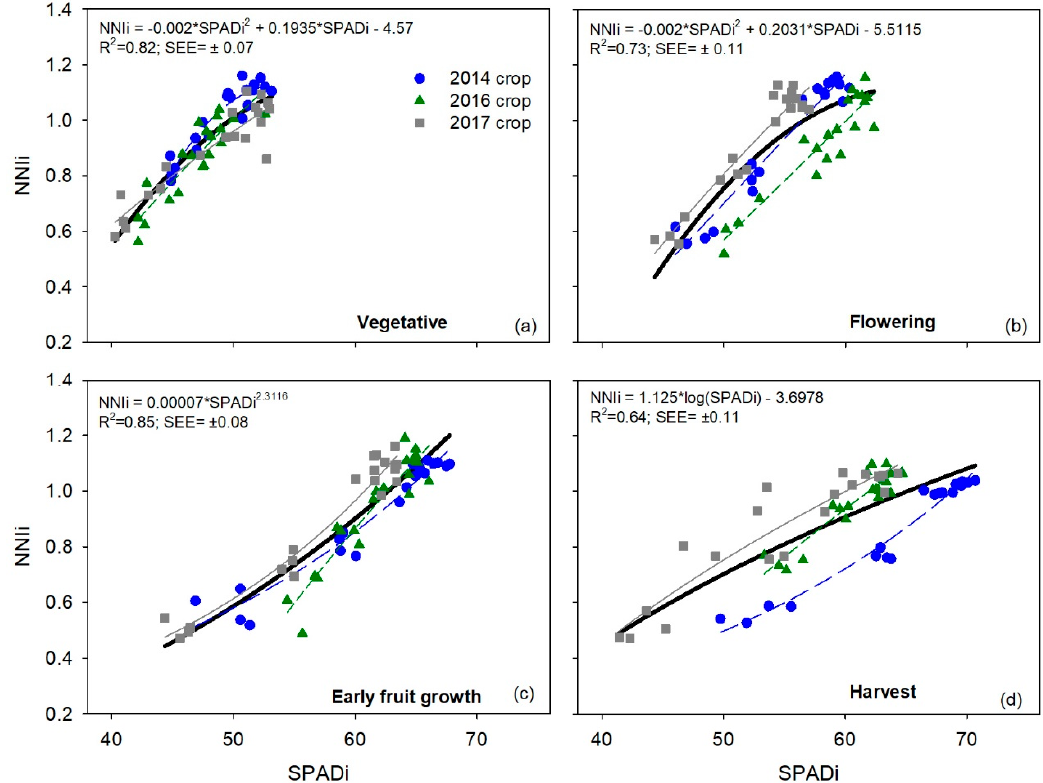
Figure 3. Relationships between integrated SPAD ( SPADi ) values and the integrated crop nitrogen nutrition index ( NNIi ) for each phenological stage in each of the three sweet pepper ( Capsicum annuum ) crops. Each crop was subjected to five different N treatments with four repetitions. The bold black line and the equation represent the adjustment for the combined dataset of the three crops together. Results of regression for each crop separately are in Table 6.